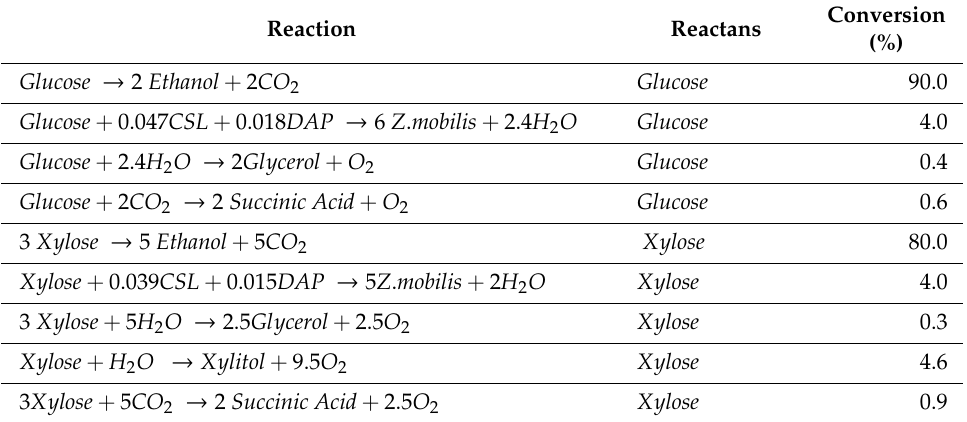
Table 1. Chemical reaction involving xylose and glucose with enzymes.